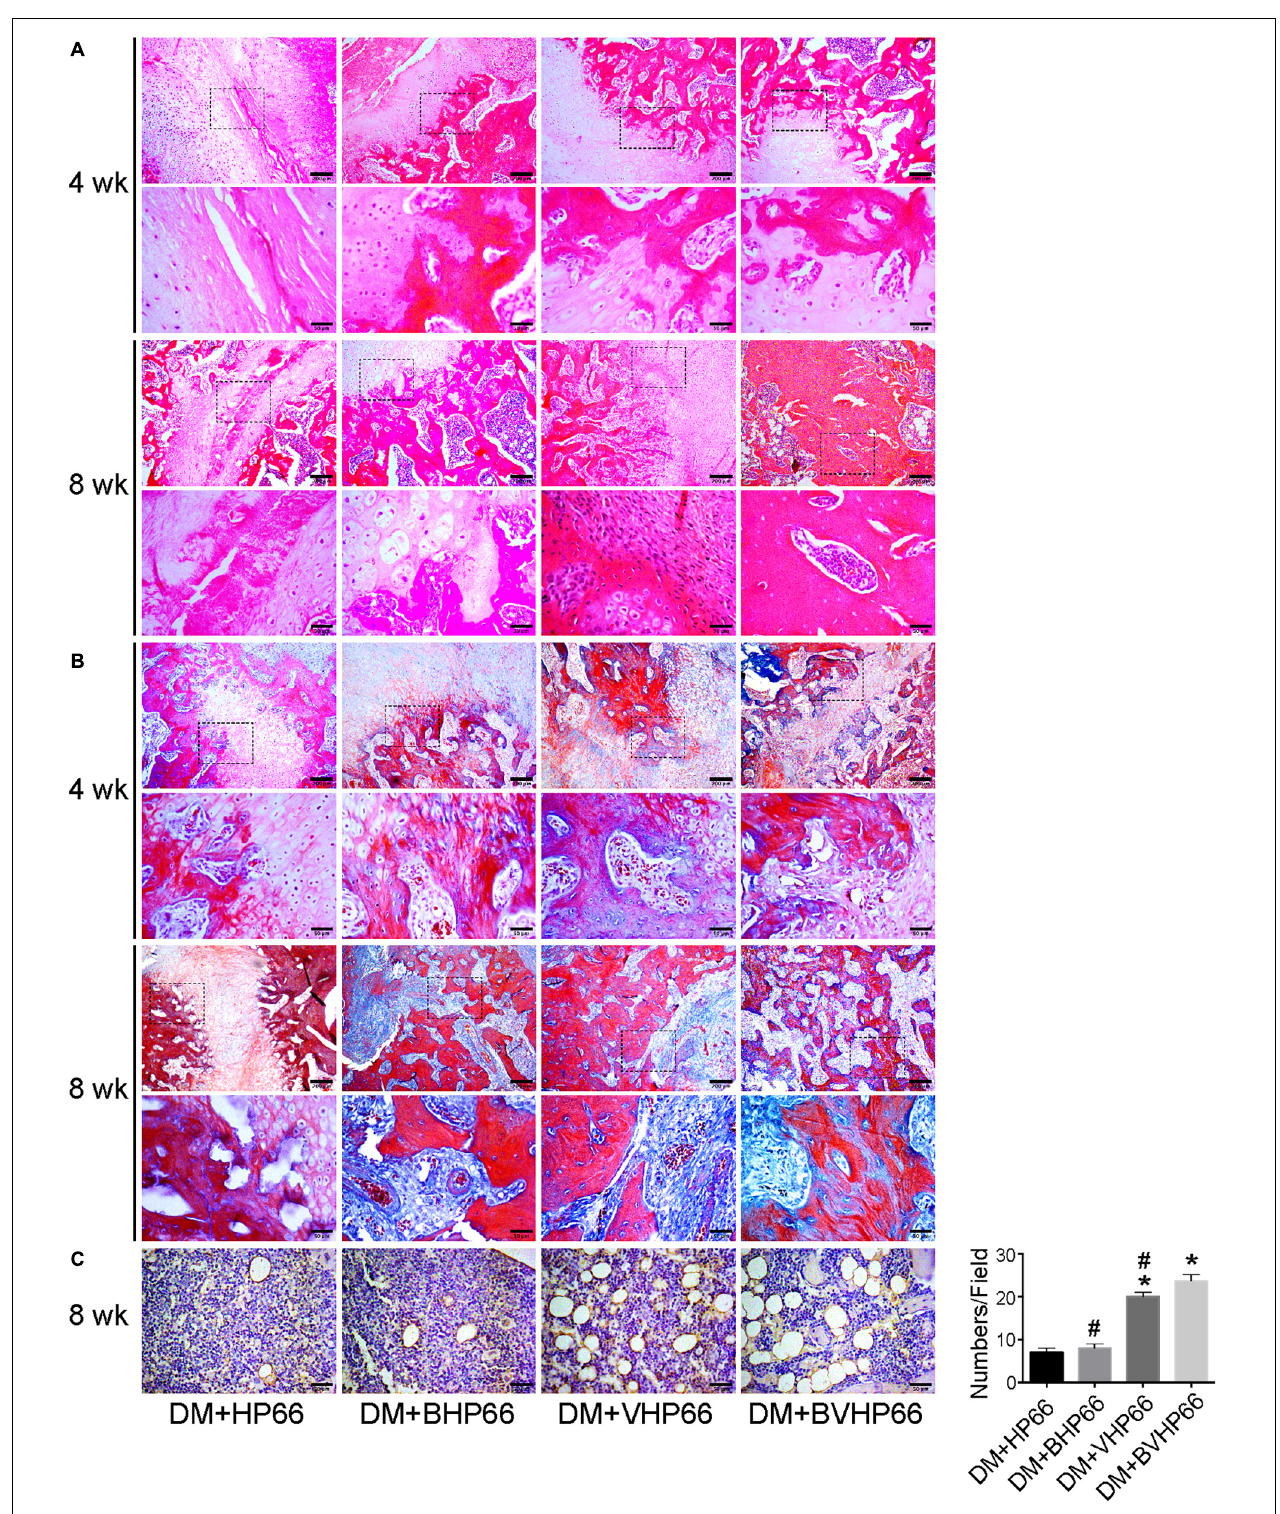
FIGURE 10 | Histological analysis. Representative histological sections after (A) H&E staining, (B) Masson’s trichrome staining, and (C) immunohistochemistry of CD31. Moreover, the number of vessels in the field was displayed in the graph. Scale bar = 200 and 50 µ m. n = 3 for each group, data were expressed as mean ± SD. * P < 0.05, vs. HG + HP66 group; # P < 0.05, vs. HG + BVHP66 group.